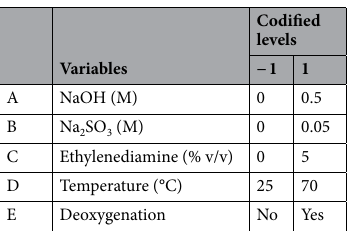
Table 2. Variable and levels used in the full factorial screening design.